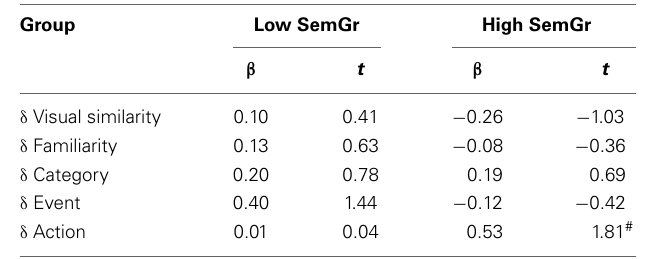
Table 5 | Coefficients for Step 3 for Th + A vs. Th-A triads; groups defined by semantic gesture recognition